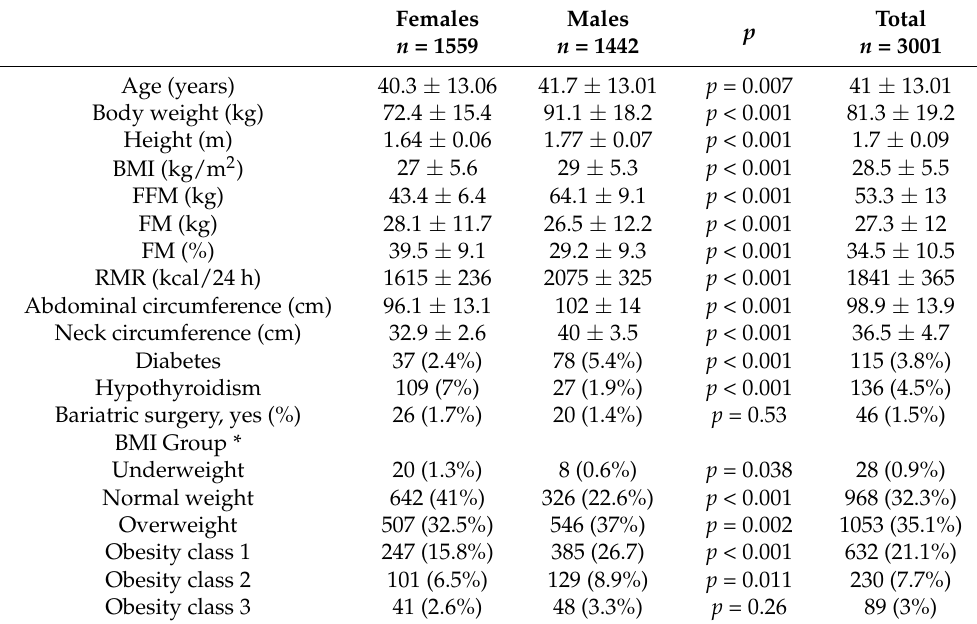
Table 1. Characteristics of the study population according to